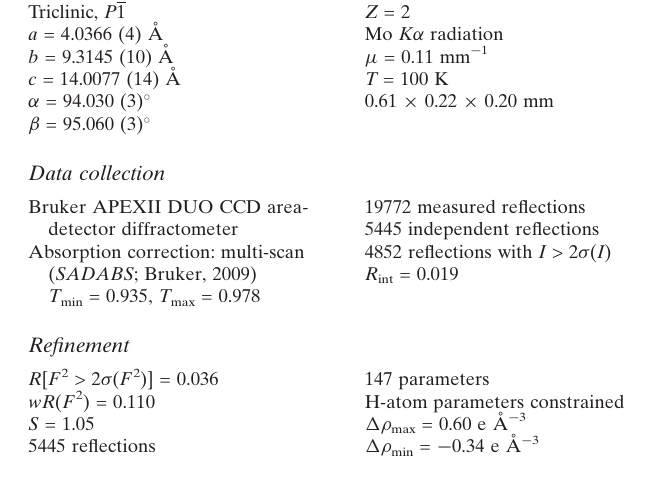
Bruker APEXII DUO CCD area- detector diffractometer